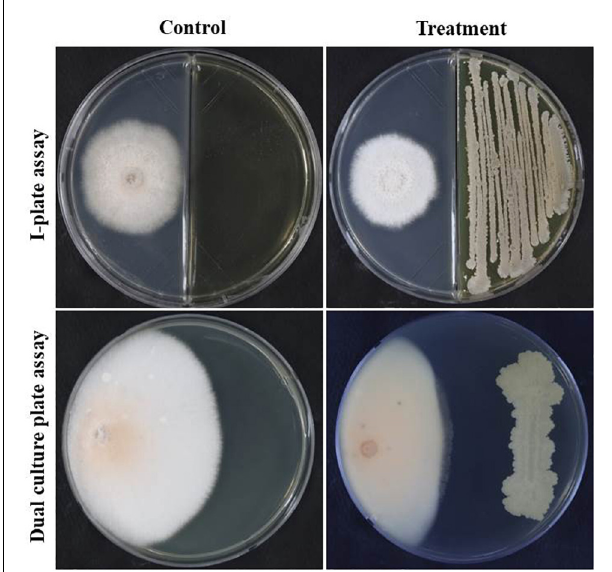
FIGURE 4 | Inhibition of Colletotrichum acutatum mycelial growth by bacterial volatiles produced by GYUN-300 under in vitro conditions using the I-plate and dual culture plate assays. Growth inhibition was observed in the I-plate and dual culture plate assays by volatiles in comparison with the non-treated